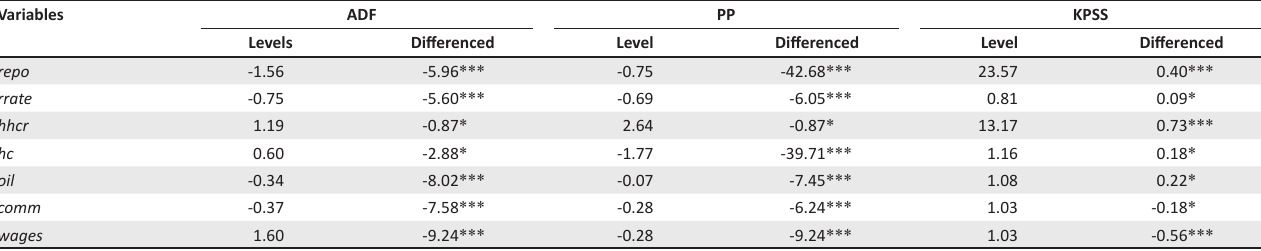
TABLE 2-A1: Order of integration of the variables.